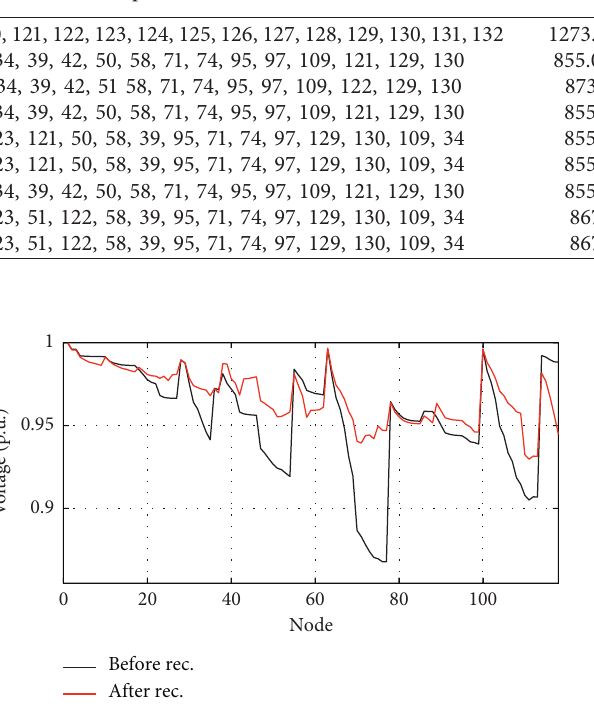
Figure 17: Voltage profile obtained for the 119-node